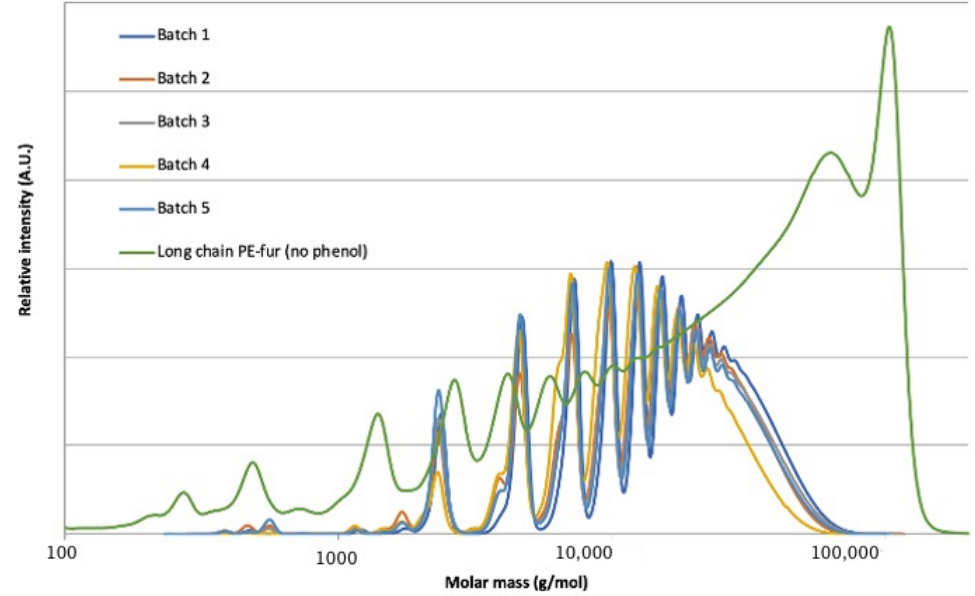
Figure 2. GPC spectrum of multiple PE-fur batches (for reaction conditions see Experimental Sec-